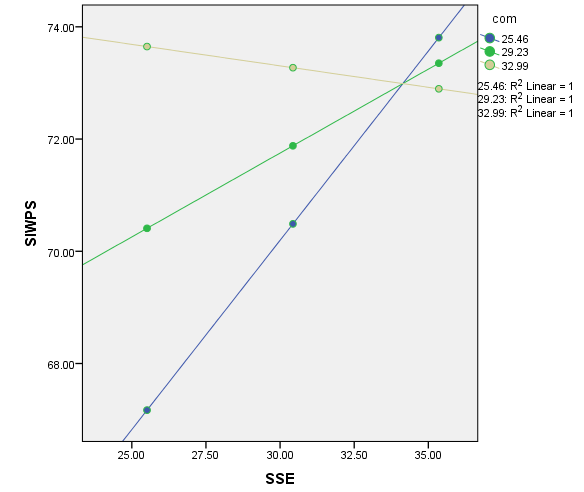
Fig. 2: Theoretical